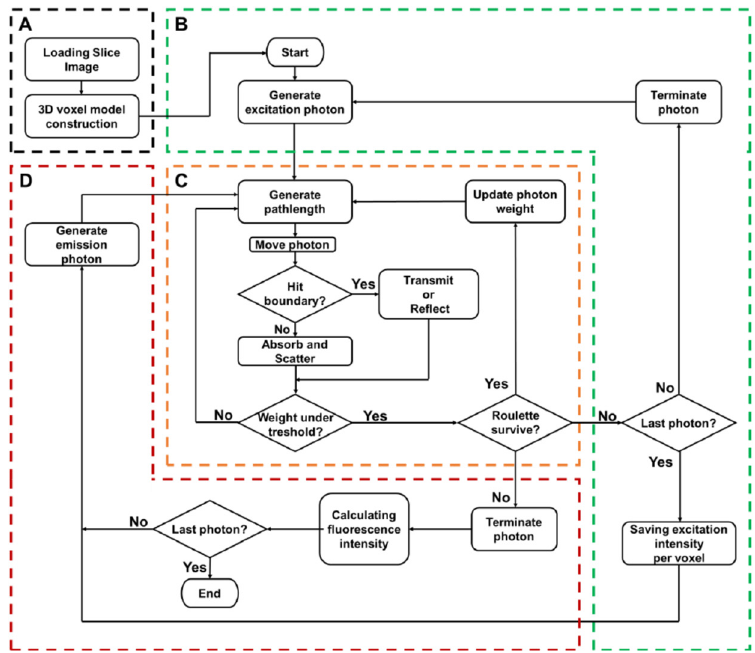
Figure 3. FlowchartoftheMonteCarlosimulationinvoxelizedmediaforbreasttissue. ( A )Implementation of the breast anatomical data of the VHP. ( B ) Excitation part of the simulation. ( C ) Computation routines were based on Wang et al. [25]. ( D ) Emission